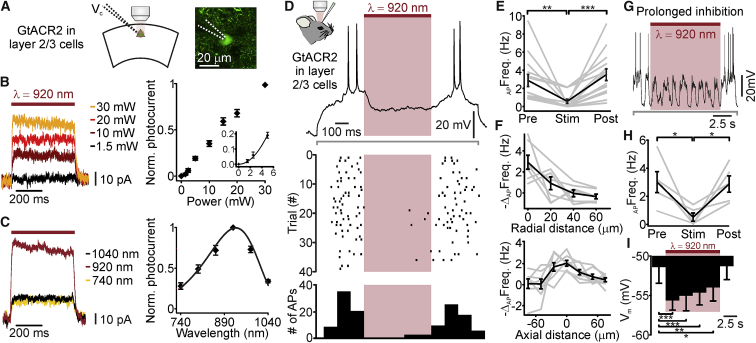
Two-Photon Holographic Activation of GtACR2 Allows Optogenetic Inhibition with High Spatial Resolution In Vitro and In Vivo(A) Left: schematic of the experimental configuration for slice recording. Neurons expressing GtACR2 were recorded in voltage-clamp configuration (Vc) and held at −50 mV while holographic illumination with an elliptical shape was performed. Chloride equilibrium potential: −68 mV. Right: two-photon image of a layer 2/3 neuron expressing GtACR2-eGFP that was recorded in voltage-clamp configuration. The glass pipette (dotted lines) was filled with Alexa Fluor 488 (green cytosolic signal).(B) Left: GtACR2-mediated photocurrents evoked by holographic illumination at different illumination powers. Traces are averages of 3 stimulation trials. Right: average peak photocurrent evoked by holographic illumination at various laser powers. λexc = 920 nm. In each cell, photocurrent values were normalized to the maximal photocurrent recorded at 30 mW light power. The inset displays the nonlinear dependence of photocurrents on the laser power at low power values. N = 7–11 cells from 2 to 3 mice.(C) Left: traces showing GtACR2 photocurrents evoked by holographic illumination at different wavelengths. Traces are averages of 4 stimulation trials. Average laser power: 25 mW. Right: average GtACR2 peak photocurrent evoked by holographic illumination as a function of the stimulation wavelength. Photocurrent values were normalized to the peak photocurrent at 920 nm. Values were fitted with a three-parameter Weibull function. N = 9 cells from 4 mice. Laser power: 20–30 mW.(D) Top: membrane potential of one layer 2/3 GtACR2-expressing neuron recorded in whole-cell configuration in vivo during simultaneous current injection (gray line below the trace; current amplitude: 70 pA) and two-photon holographic illumination (red bar). Laser power: 80 mW; stimulus duration: 500 ms. Inset: schematic of the experimental configuration in vivo. Middle: raster plot showing cell response over consecutive trials for the same cell displayed in the top panel. Bottom: AP distribution for the trials shown in the middle panel (time bin: 100 ms).(E) Average firing frequency Pre, during (Stim), and Post holographic stimulation of GtACR2-expressing layer 2/3 neurons. Holographic illumination was performed while injecting a small depolarizing current. Average current amplitude: 74 pA, range: 50–100 pA. p = 1.8E−5, Friedmann test with Dunn’s correction, N = 14 cells from 7 mice. Average laser power: 50 mW, range: 10–80 mW.(F) Firing frequency decrease versus displacement of the excitation volume in the radial (top) and axial (bottom) directions during holographic illumination. Top: N = 7 cells from 4 mice. Bottom: N = 8 cells from 5 mice.(G) Same as (D), but for a prolonged period of illumination (10 s). Injected current amplitude: 70 pA; laser power: 80 mW.(H) Same as (E) but for prolonged illumination. Average injected current amplitude: 50 pA, range: 30–70 pA. p = 9.4E−3, ANOVA with Bonferroni’s correction, N = 5, from 2 mice. Laser power: 80 mW.(I) Membrane potential Pre, during (Stim), and Post prolonged inhibition of layer 2/3 neurons with holographic stimulation of GtACR2 (time bins: 2.5 s). p = 7E−6, ANOVA test with Bonferroni’s correction, N = 5, from 2 mice. Laser power: 80 mW.In this figure, the black line represents the average and SEM, individual experiments are depicted in gray. See also Tables S1 and S2.